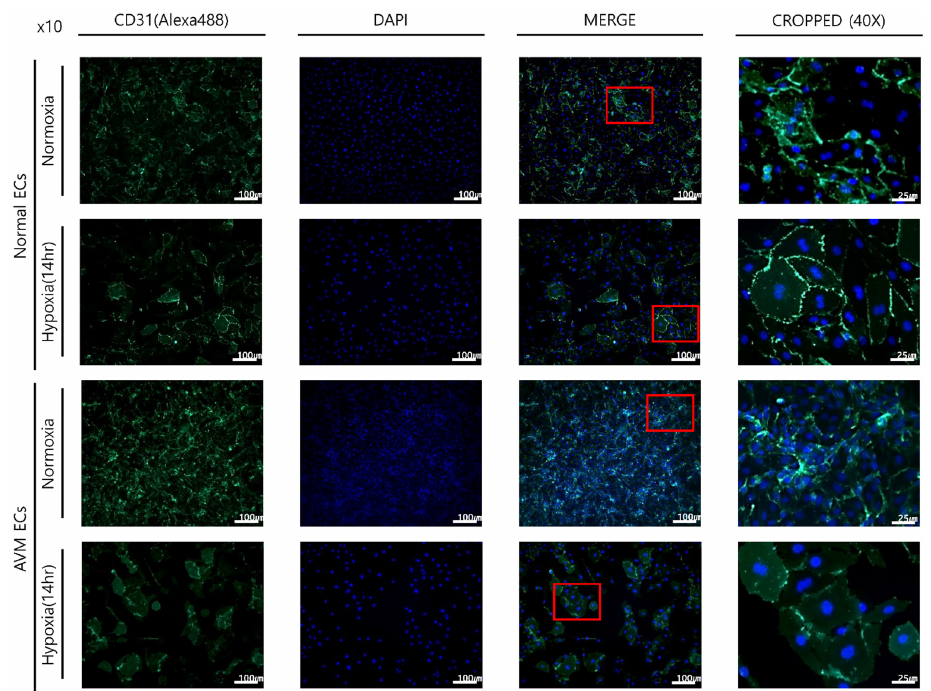
Figure 1. Comparison of immunofluorescence imaging after incubation under each condition for 14 h. Under normoxia, compared to that of normal ECs, AVM ECs showed higher endothelial cell proliferation. Under hypoxia, the overall proliferation of endothelial cells in both normal and AVM ECs decreased; however, proliferation increased in AVM ECs compared to that of normal ECs. AVM, arteriovenous malformation; EC, endothelial cell. Red box means Cropped (40X) image. The comparison of CD31 expression in normal ECs and AVM ECs was assessed using immunofluorescence microscopic image analysis after incubation under each condition (normoxia and hypoxia) for 14 h. Under normoxia, CD31 immunoreactivity was found in 79.23 (±0.65%) of the area in AVM ECs, which was greater than that in normal ECs (74.15 ± 0.70%). Similarly, under hypoxia, CD31 immunoreactivity was found in 63.85 (±1.84%) of the area in AVM ECs, which was significantly higher than that in normal ECs (60.52 ± 0.51% in normal ECs), suggesting that angiogenesis is more active in AVM ECs (Figure 2).